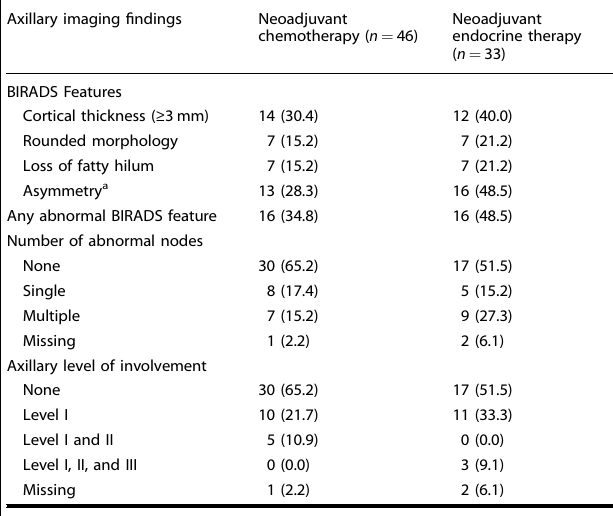
Table 2. Appearance of axillary nodes on post-treatment breast MRI. Axillary imaging fi ndings